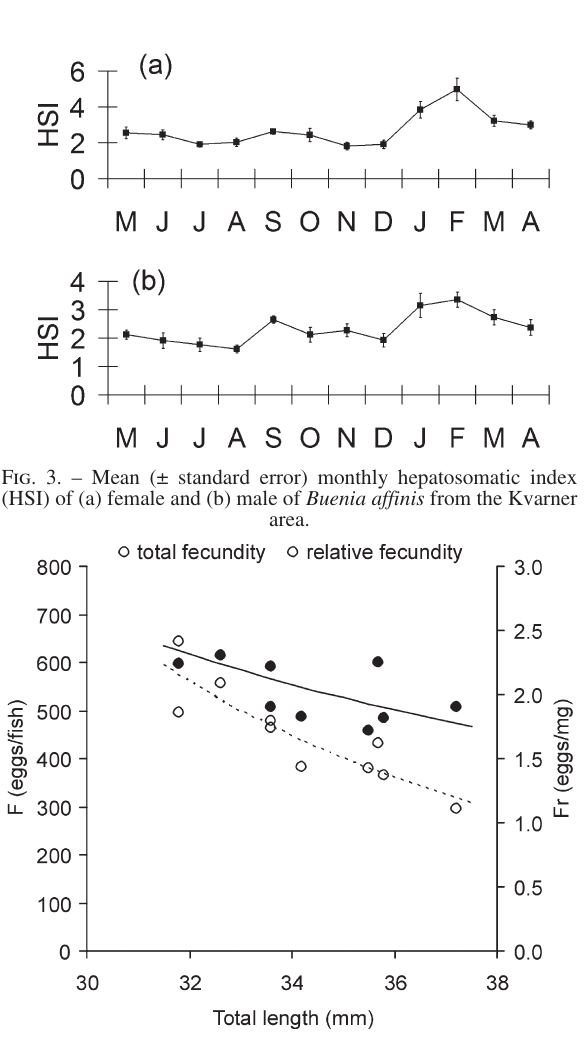
Fig. 4. – Plot of absolute fecundity and relative fecundity against total length of Buenia affinis from the Kvarner